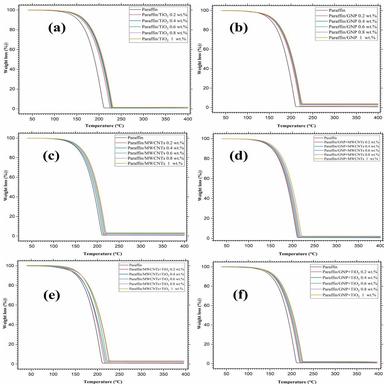
TGA curves of single and hybrid nano enhanced PCMs (a) PAR + TiO2, (b) PAR + GNP, (c) PAR + MWCNTs, (d) PAR/MWCNTs + GNP, (e) PAR/MWCNTs + TiO2, and (f) PAR/ GNP + TiO2.